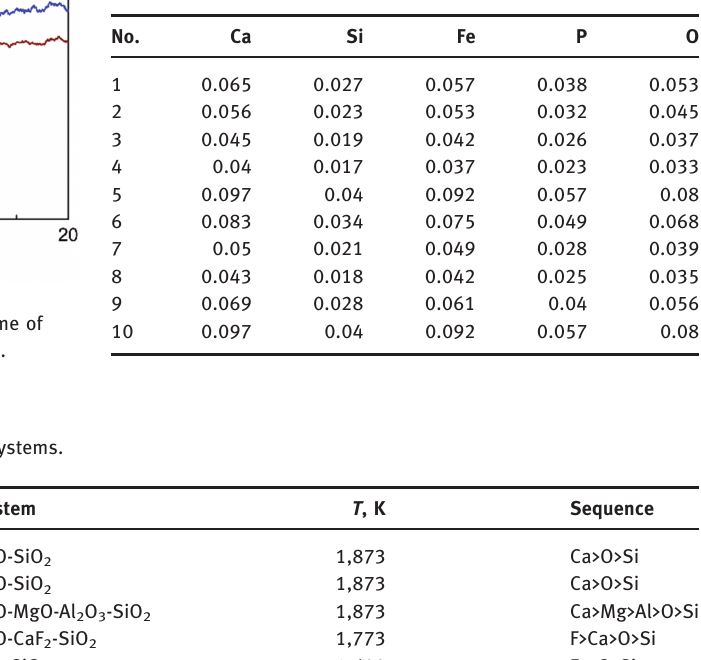
Table 4: Self-diffusion coefficients of different ions /(Å 2